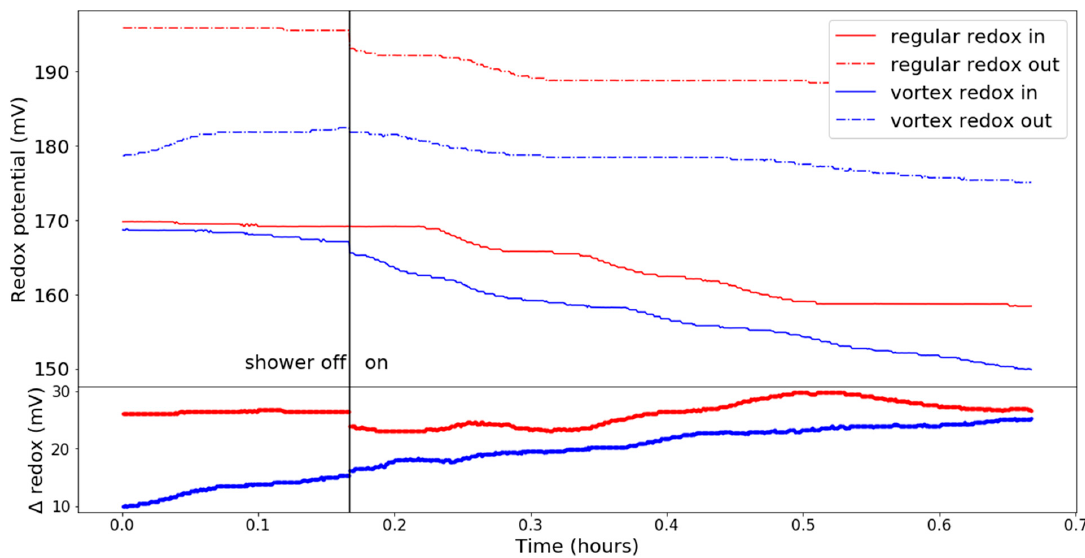
Figure 10. Redox potential against time for both showerheads before (full) and after (dot-dashed) the spray in a circulating water setup. The lower part is the difference between the two redox potential sensors for both showerheads.